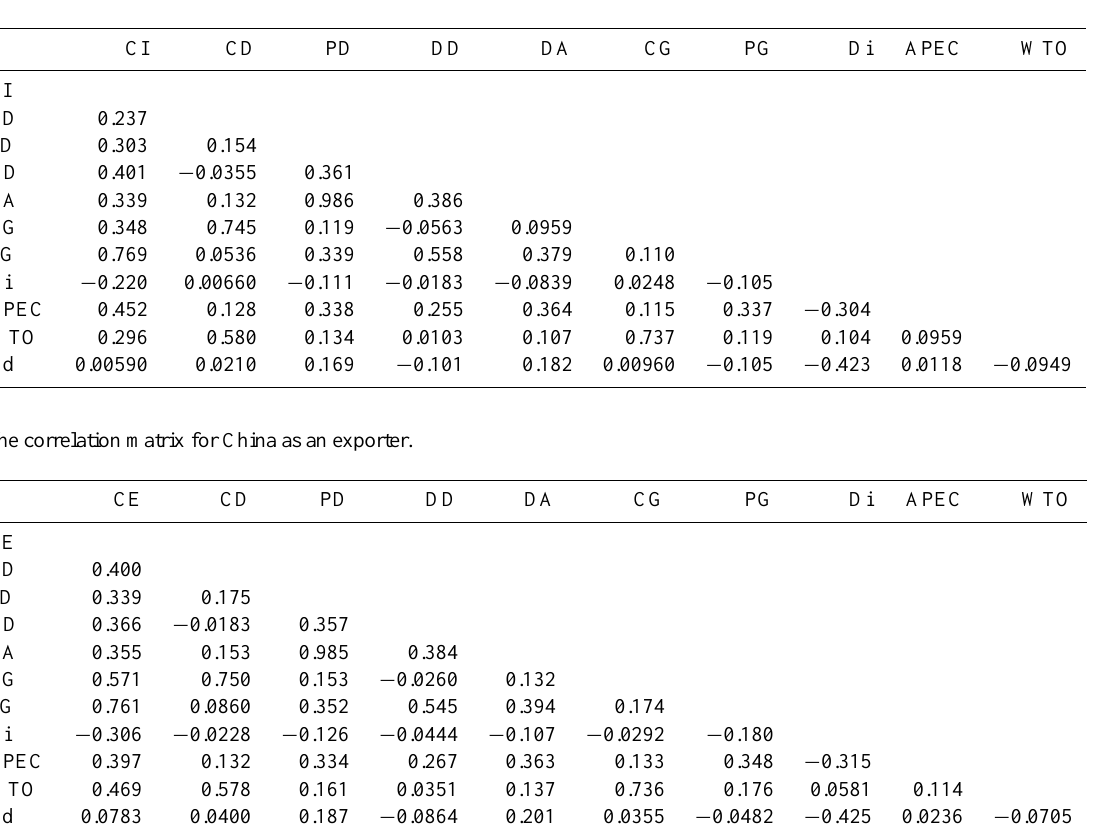
Table 2. The correlation matrix for China as an importer.